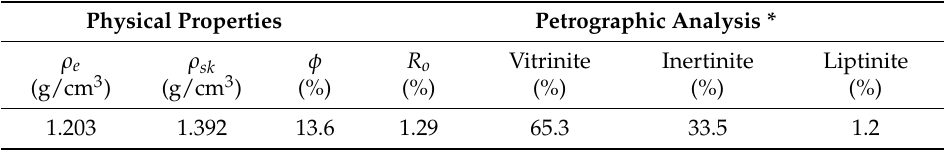
Table 1. Properties of the coal sample.